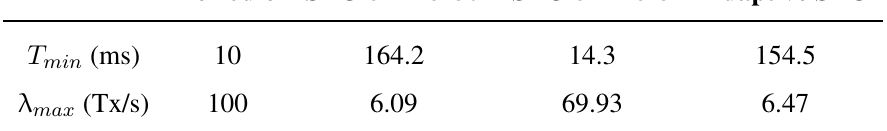
Table 2. Maximum transmission rate with the three different implementations of the controller. STC, self-triggered control.